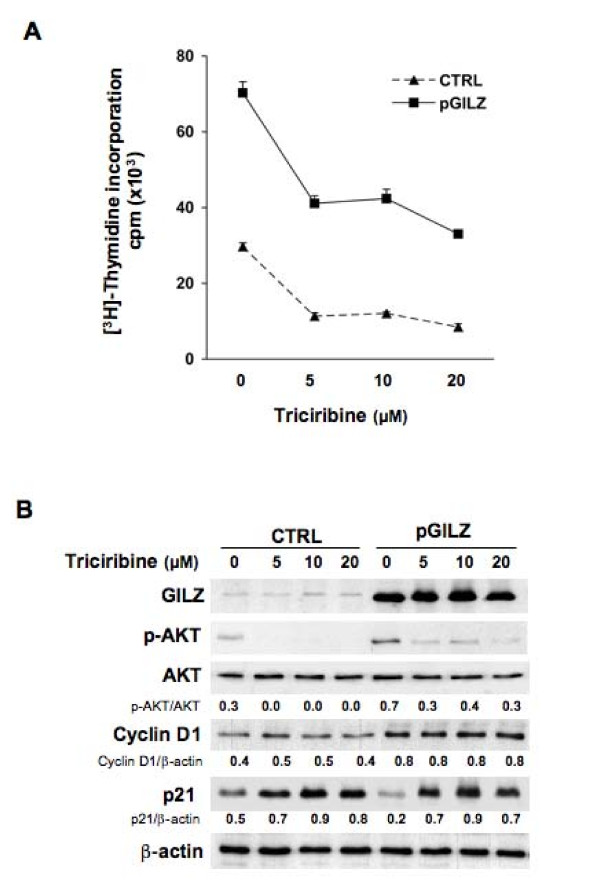
AKT activation is required for BG-1 cell proliferation. (A) Cell proliferation was measured by [3H]-thymidine incorporation in CTRL and pGILZ clones treated with indicated Triciribine doses for 24 h. Results are means ± SE of 3 independent experiments. (B) western blots of total protein lysates from CTRL or pGILZ clones treated with indicated Triciribine doses for 24 h. Membranes were probed with specific antibodies. The expression of GILZ, p-AKT, cyclin D1 and p21 proteins were quantified by densitometric analysis and normalized to β-actin or total AKT; results are expressed as GILZ/β-actin, p-AKT/AKT, cyclin D1/β-actin or p21/β-actin ratios. Blots: one representative experiment of three.